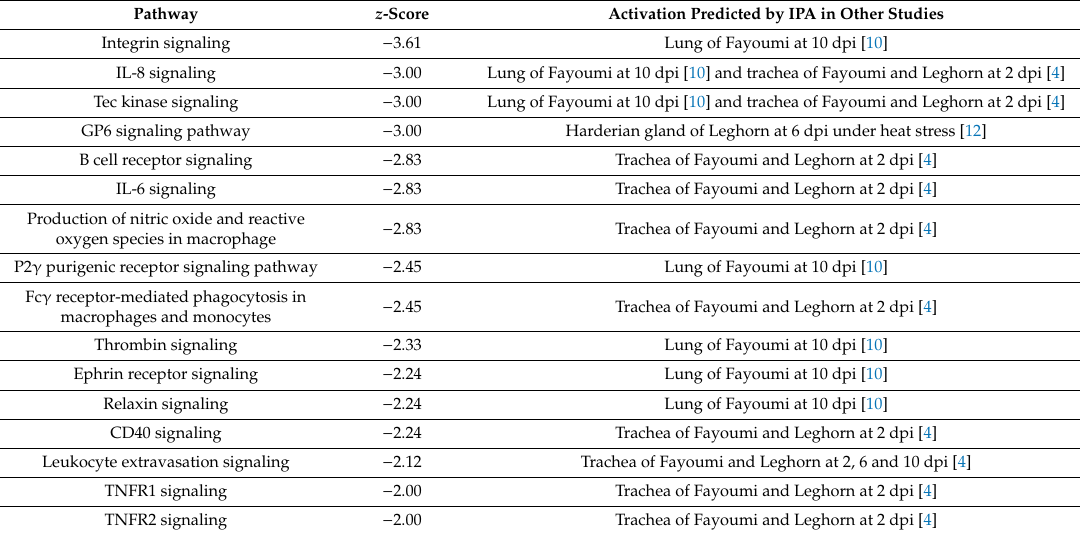
Table 6. Pathways found to be significantly inhibited by NDV in the present study ( z -score < − 2) and identified to be activated by NDV in other studies, as predicted by